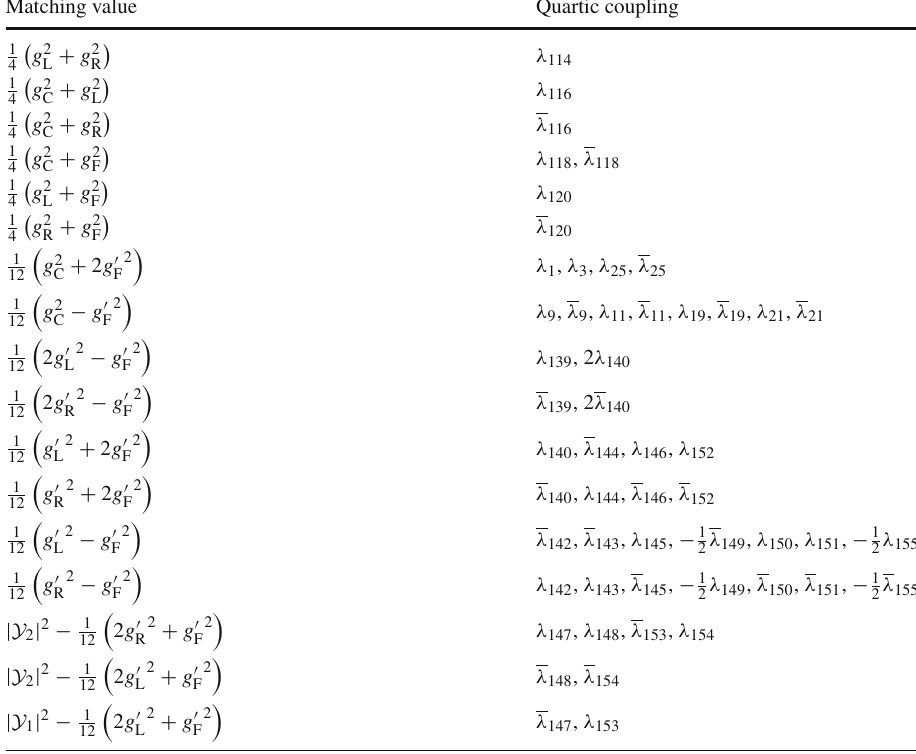
Table 15 Scalar quartic Matching value Quartic couplings matching conditions with two D-term interactions.